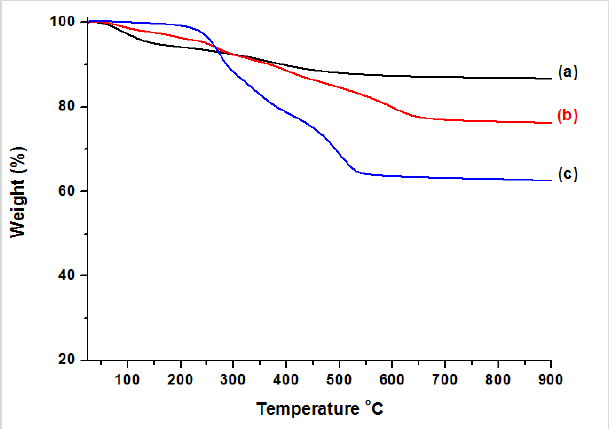
Figure 9. Thermogravimetric analysis (TGA) curves of ( a ) MNP-OA, ( b ) Magnetic Ethylene-PMO NPs, and ( c ) Magnetic Phenylene-PMO NPs.